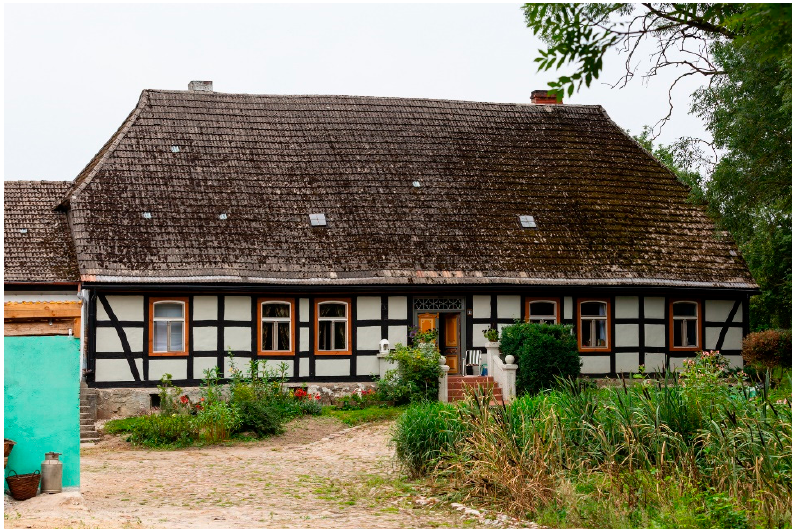
Figure 1. A historical half-timber house of 1856. Created by author.